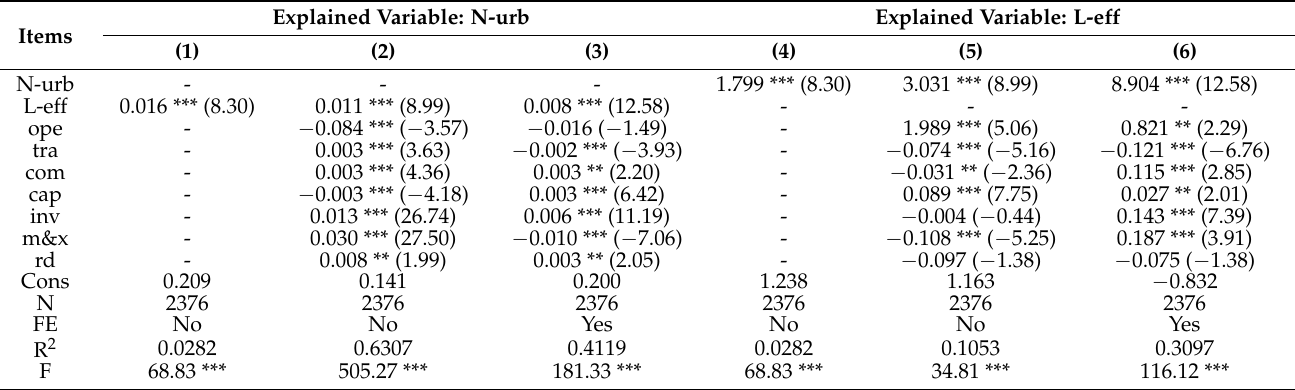
Table 5. Benchmark regression results.